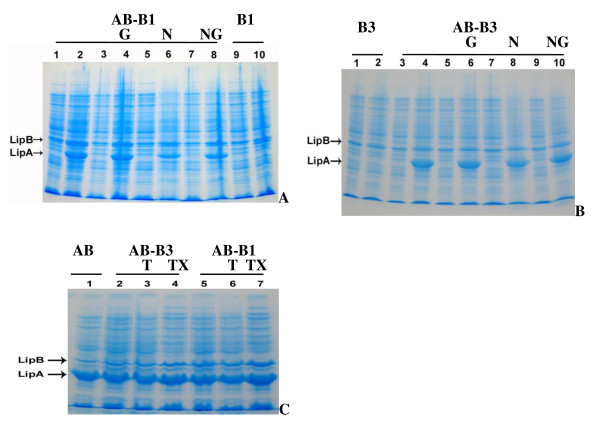
SDS-PAGE of BL21 cell lysates harboring the recombinant plasmids. (A). pELipAB-LipB1a (1-8) and pELipB1k (9-10). LB medium without addititive (1-2), with 0.5% (v/v) of Neptune oil (5-6), 0.5% (w/v) of gum Arabic (3-4), 0.5% (w/v) of gum Arabic + 0.5% (v/v) of Neptune oil (7-8). Odd and even lanes indicated induction by IPTG for 0 and 4 hours, respectively. (B). pELipB3k (1-2) and pELipAB-LipB3a (3-10). LB medium without additive (3-4), with 0.5% (w/v) of gum Arabic (5-6), 0.5% (v/v) of Neptune oil (7-8), 0.5% (w/v) of gum Arabic + 0.5% (v/v) of Neptune oil (9-10). Odd and even lanes indicated induction by IPTG for 0 and 4 hours, respectively. (C). pELipABa (1); pELipAB-LipB3a (2-4), pELipAB-LipB1a (5-7). LB medium without additive (1, 2, 5), with 0.5% of Tween 80 (3, 6), and 0.5% of Triton X-100 (4, 7) after induction by IPTG for 4 hours.